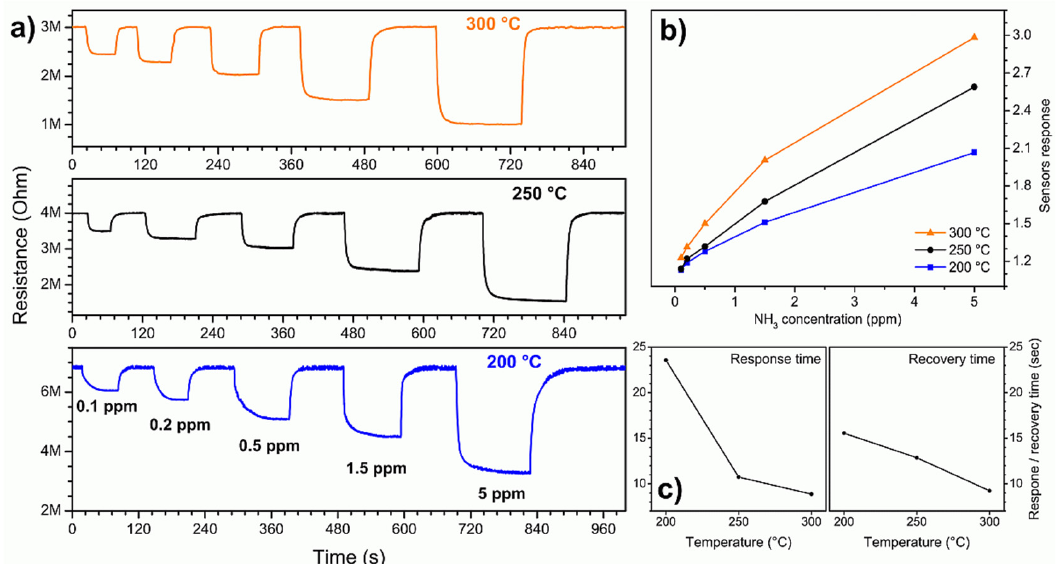
Figure 3. ( a ) Dynamic resistance at three temperature values during the injection of different concentrations of ammonia; ( b ) sensor response as a function of the ammonia concentration for different working temperatures; ( c ) response and recovery times as a function of the sensor working temperature.